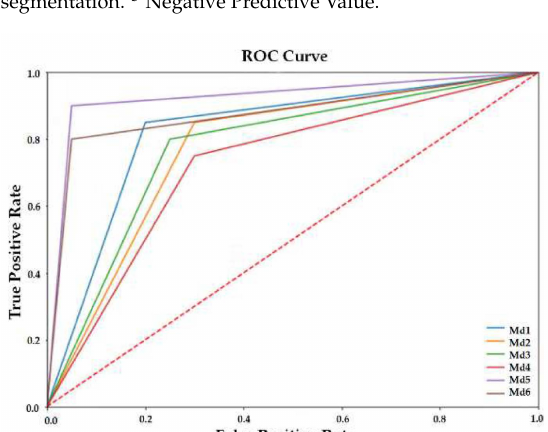
Figure 3. ROC curves of pipelines used for detecting PNI across various segmentation models. The results revealed that Md5, using a multi-class segmentation network, achieved the highest AUC of